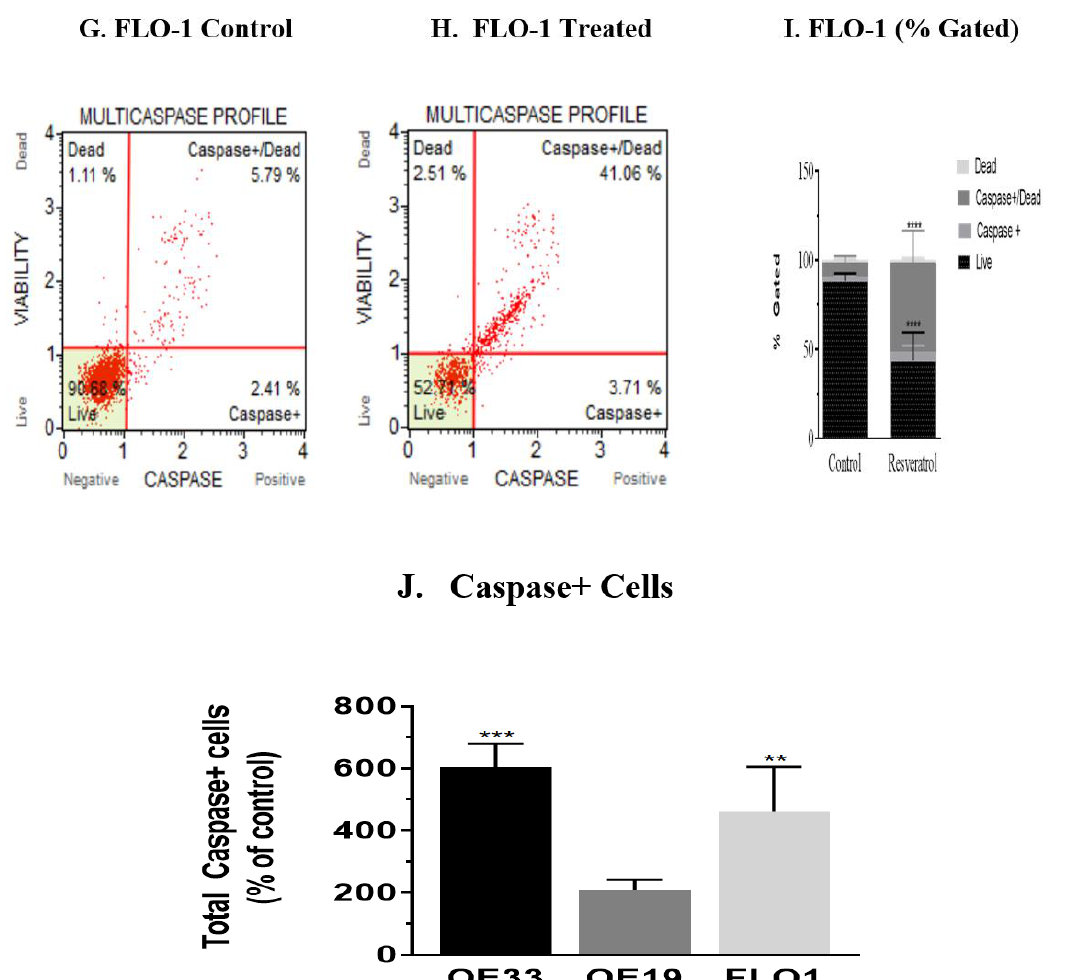
Figure 3. Activation of caspases on treatment with resveratrol in OE33, OE19 and FLO-1 cells. Cells were seeded at a density of 62,500 cells/well in 12-well plates and treated with resveratrol at 100 µ M for OE33 cells for 72 h. Three independent experiments were performed. ( A ) Representative scatter plot from Muse MultiCaspase assay for the control group. ( B ) Representative scatter plot from Muse MultiCaspase assay for the resveratrol-treated group. ( C ) Profiles (% gated) of the control and treated group, respectively. Similarly, OE19 and FLO-1 cells were treated with resveratrol at an IC 50 concentration of 50 and 40 µ M, respectively, and analyzed by Muse flow cytometry and Muse MultiCaspase assay. Representative scatter plots of four independent trials of the control group and the treated group for OE19 cells are shown in ( D ) and ( E ), respectively. ( F ) The % gated profile of the control group and treated group for OE19 cells. Representative scatter plots of four independent trials of the control group and the treated group for FLO-1 cells are shown in ( G ) and ( H ), respectively. ( I ) The % gated profile of the control group and treated group for FLO-1 cells. ( J ) After normalizing to the control, the percent of caspase-positive cells are represented by the bar diagram for all the three cell lines. * in the bar diagram indicates p -value < 0.05. More asterisks represent higher statistical